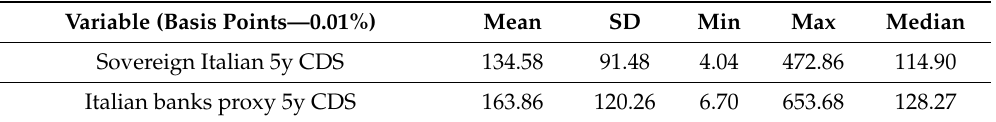
Table 1. Descriptive statistics –April 2007 to September 2018 (2859 Obs.).